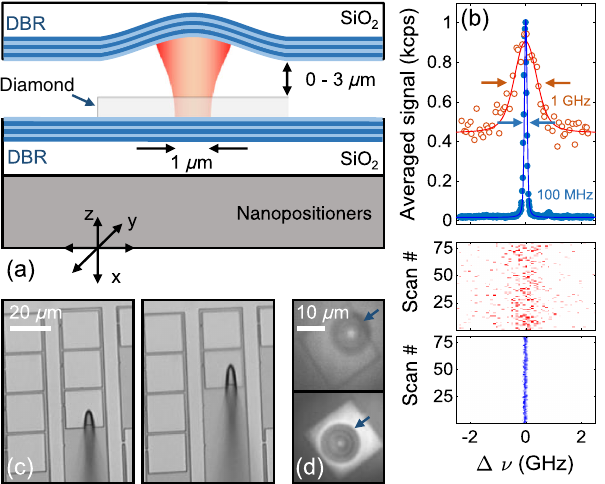
FIG. 1. (a) Schematic of the tunable microcavity containing a thin diamond membrane. Both the antinode location and reso- nance frequency of the microcavity mode can be tuned in situ . (b) PLE scans of near-surface (68 nm) NV centers in unprocessed diamond (blue symbols; the lower panel: resonant laser power 3 nW and scan speed 340 MHz = s) and in microstructured ≤ 1 μ m) diamond (red symbols; the central panel: resonant ( t d laser power 10 nWand scan speed 7 . 8 GHz = s), yielding averaged zero-phonon line widths of about 100 MHz and 1 GHz, respec- tively (upper panel). (c) Detaching a 20 × 20 μ m 2 membrane using a micromanipulator. (d) Images (recorded with a wave- length outside the DBR stop band) of the diamond microcavity demonstrating the in situ control of the lateral position. The arrows indicate the position of the concave top